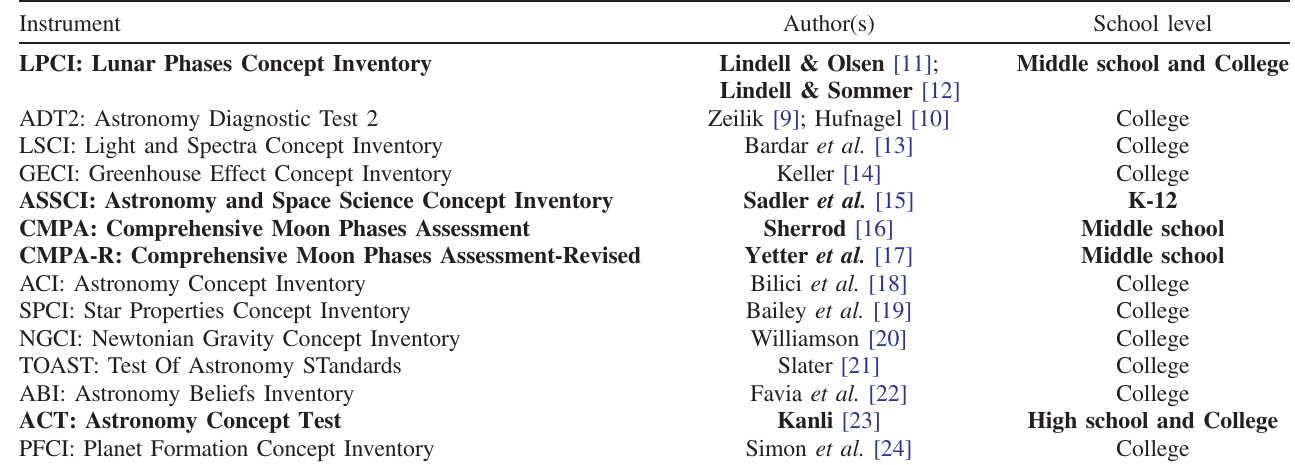
TABLE I. Currently available assessment tools about earth science, astronomy, and/or lunar phases. Instruments targeting students 10 to 14 years old are set to